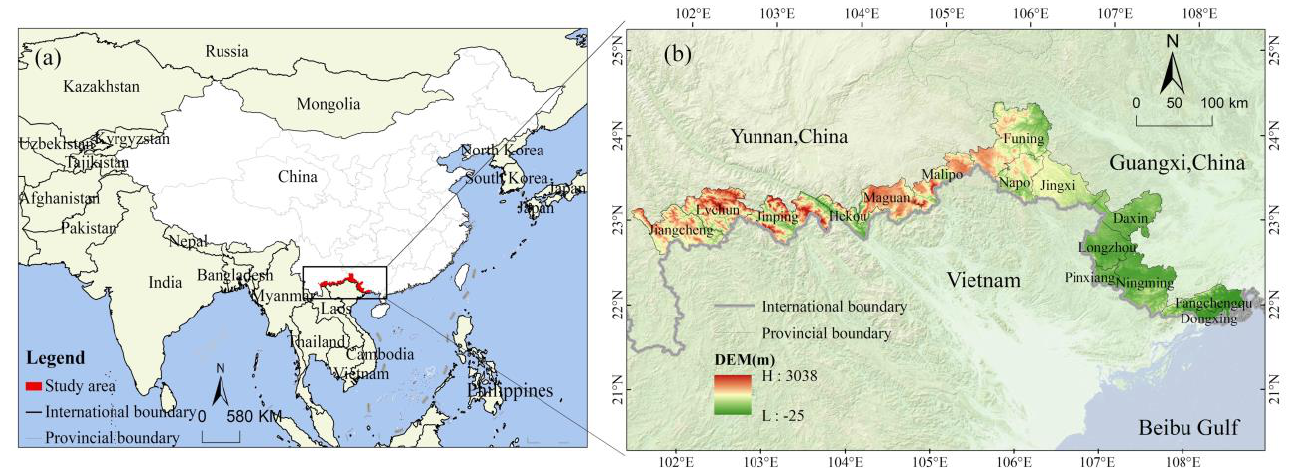
Figure 1. Location of the Sino − Vietnamese border. ( a ) The location of the Sino − Vietnamese border in China. ( b ) The basic geographic information of the study area.